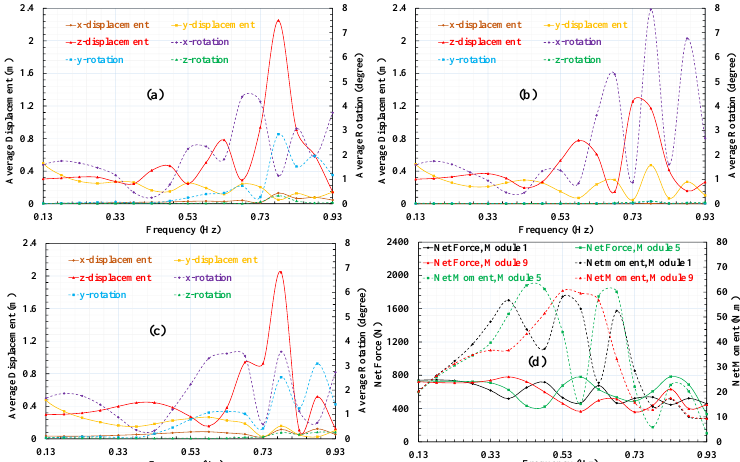
Figure 10. Average displacement of ( a ) module 1, ( b ) module 5, ( c ) module 9, and ( d ) net forces and moments corresponding to 90 ◦ of the wave direction.